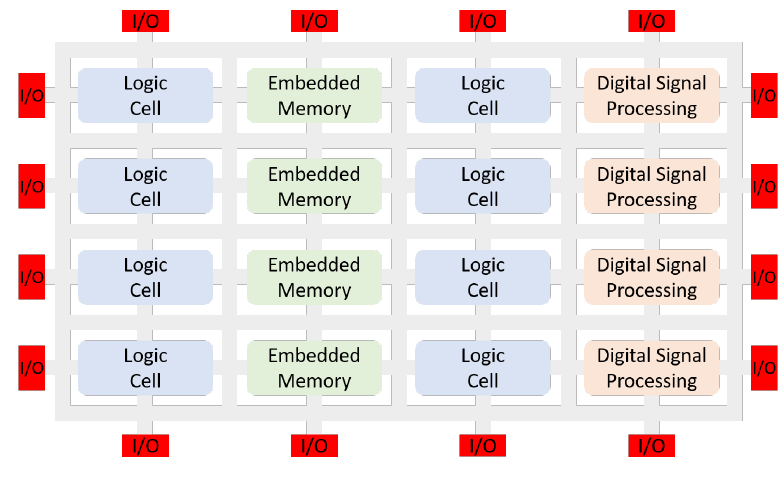
Figure 1. Superficial FPGA structure.